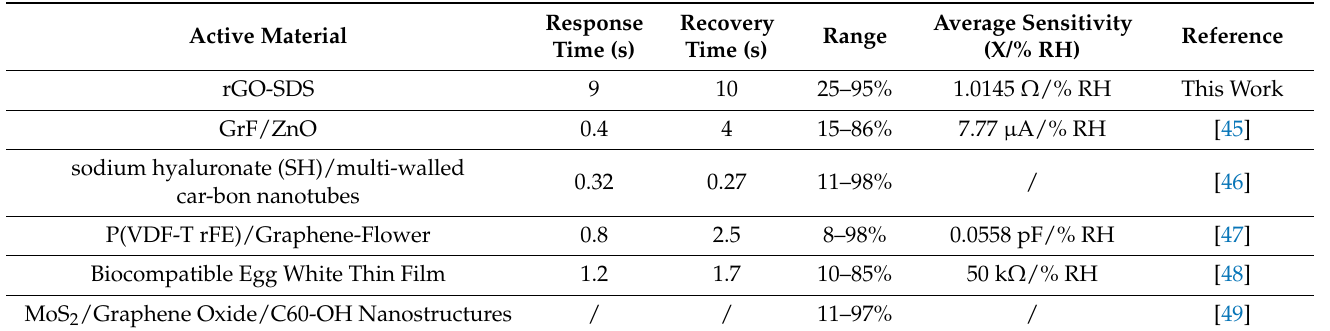
Table 2. Compared with the recently published papers on humidity